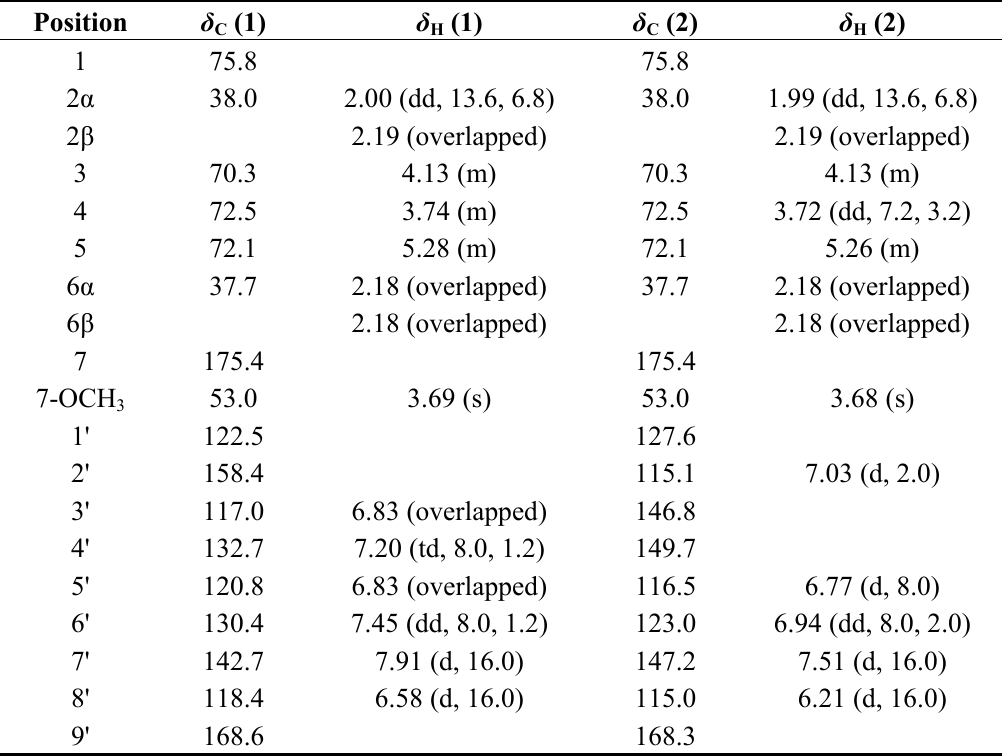
Table 1. The 1 H and 13 C-NMR spectral data of 1 and 2 ( δ in ppm and J in Hz).